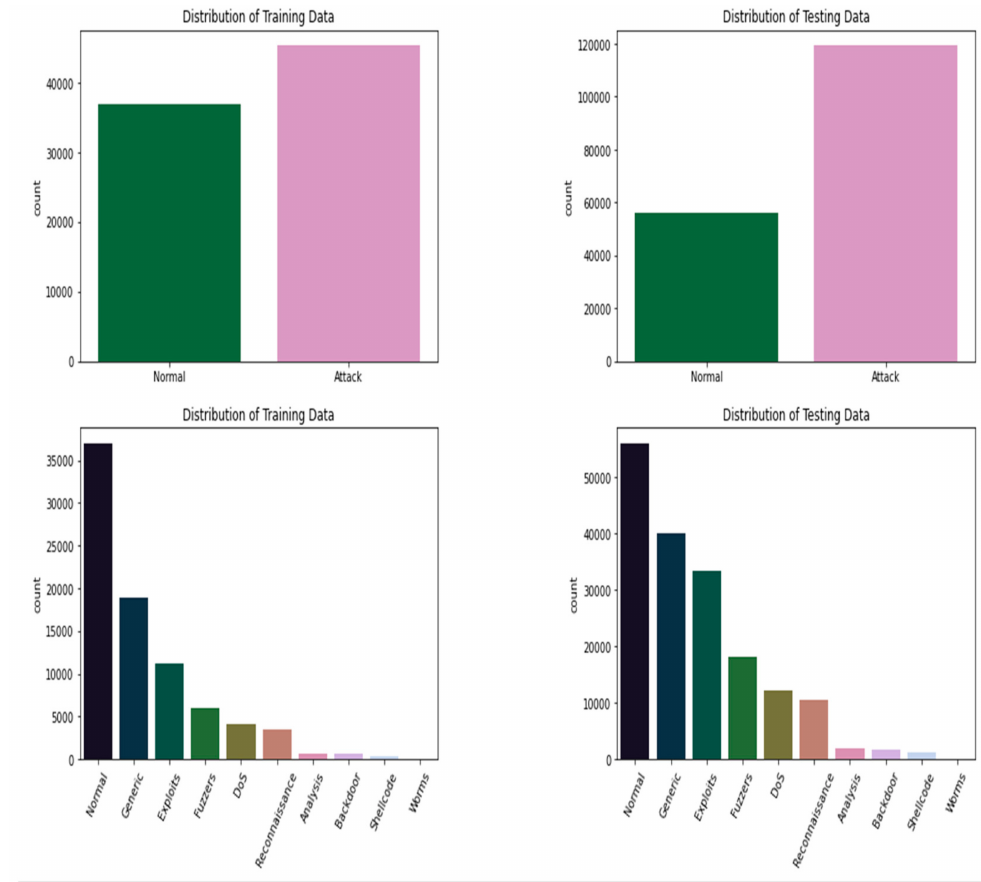
Figure 2. Dataset